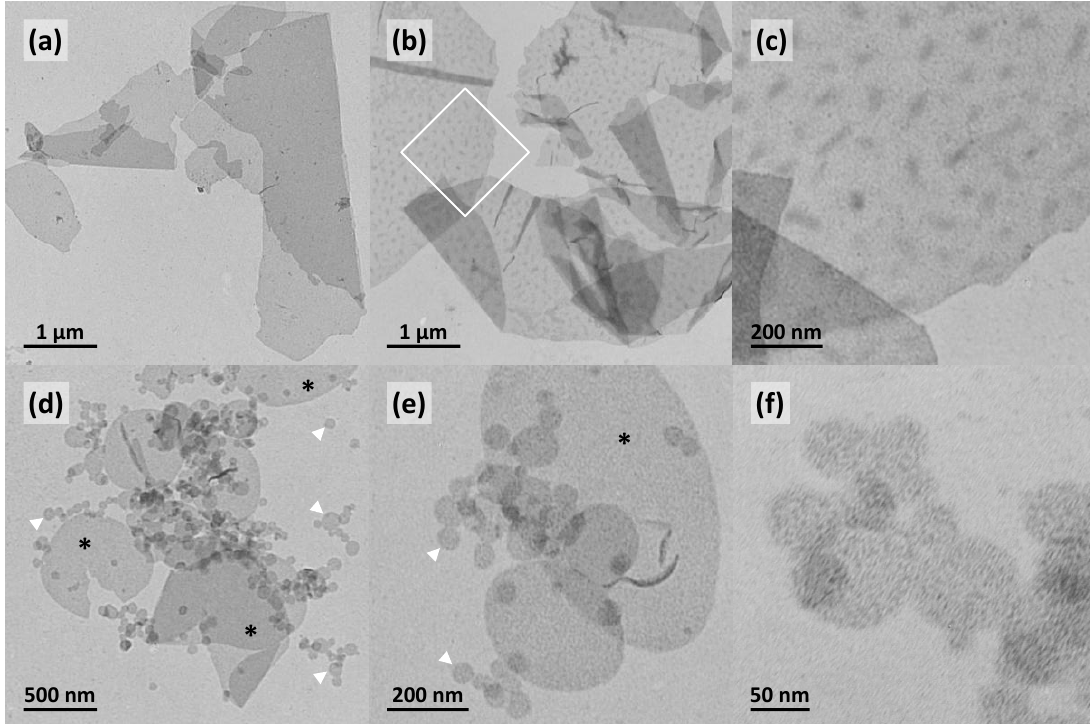
Figure 5. TEM images of aqueous suspensions ( c = 0.05 mg mL −1 ) of Me 2 PE-Gly(2C16)C32-OH : in phosphate buffer at pH = 7.7 ( a – c ); and carbonate buffer at pH = 10.0 ( d – f ), at different magnifications; the inset in ( b ) is depicted in ( c ). The black asterisks in ( d , e ) point to larger lamellar sheets, whereas the white arrowheads point to smaller, round, disk-like objects. Samples were prepared at 22 °C and stained with uranyl acetate.